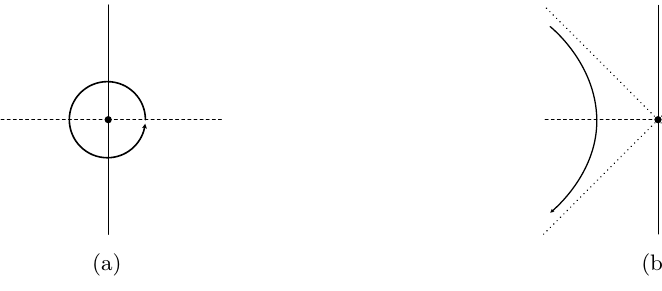
Figure 8 . Angular Quantization . When R 2 in polar coordinates (left) is continued with respect to the angular direction, the result is a wedge of the Rindler decomposition of Minkowski spacetime (right). With no operator insertions, the Euclidean functional integral over the half-plane prepares the Minkowski vacuum on the dashed line. In angular quantization, the Minkowski vacuum is identified with the TFD state in the two copies of the Hilbert space on the left and right Rindler wedges. The reduced density matrix in a single wedge is a thermal state at the Unruh temperature. To understand a Lorentzian string background with Euclidean time winding operator insertions, the neighborhood of the winding operator should be treated in angular quantization. The Hilbert space of angular quantization is a generalization of the Rindler Hilbert space, now labeled by the asymptotic condition imposed by the boundary